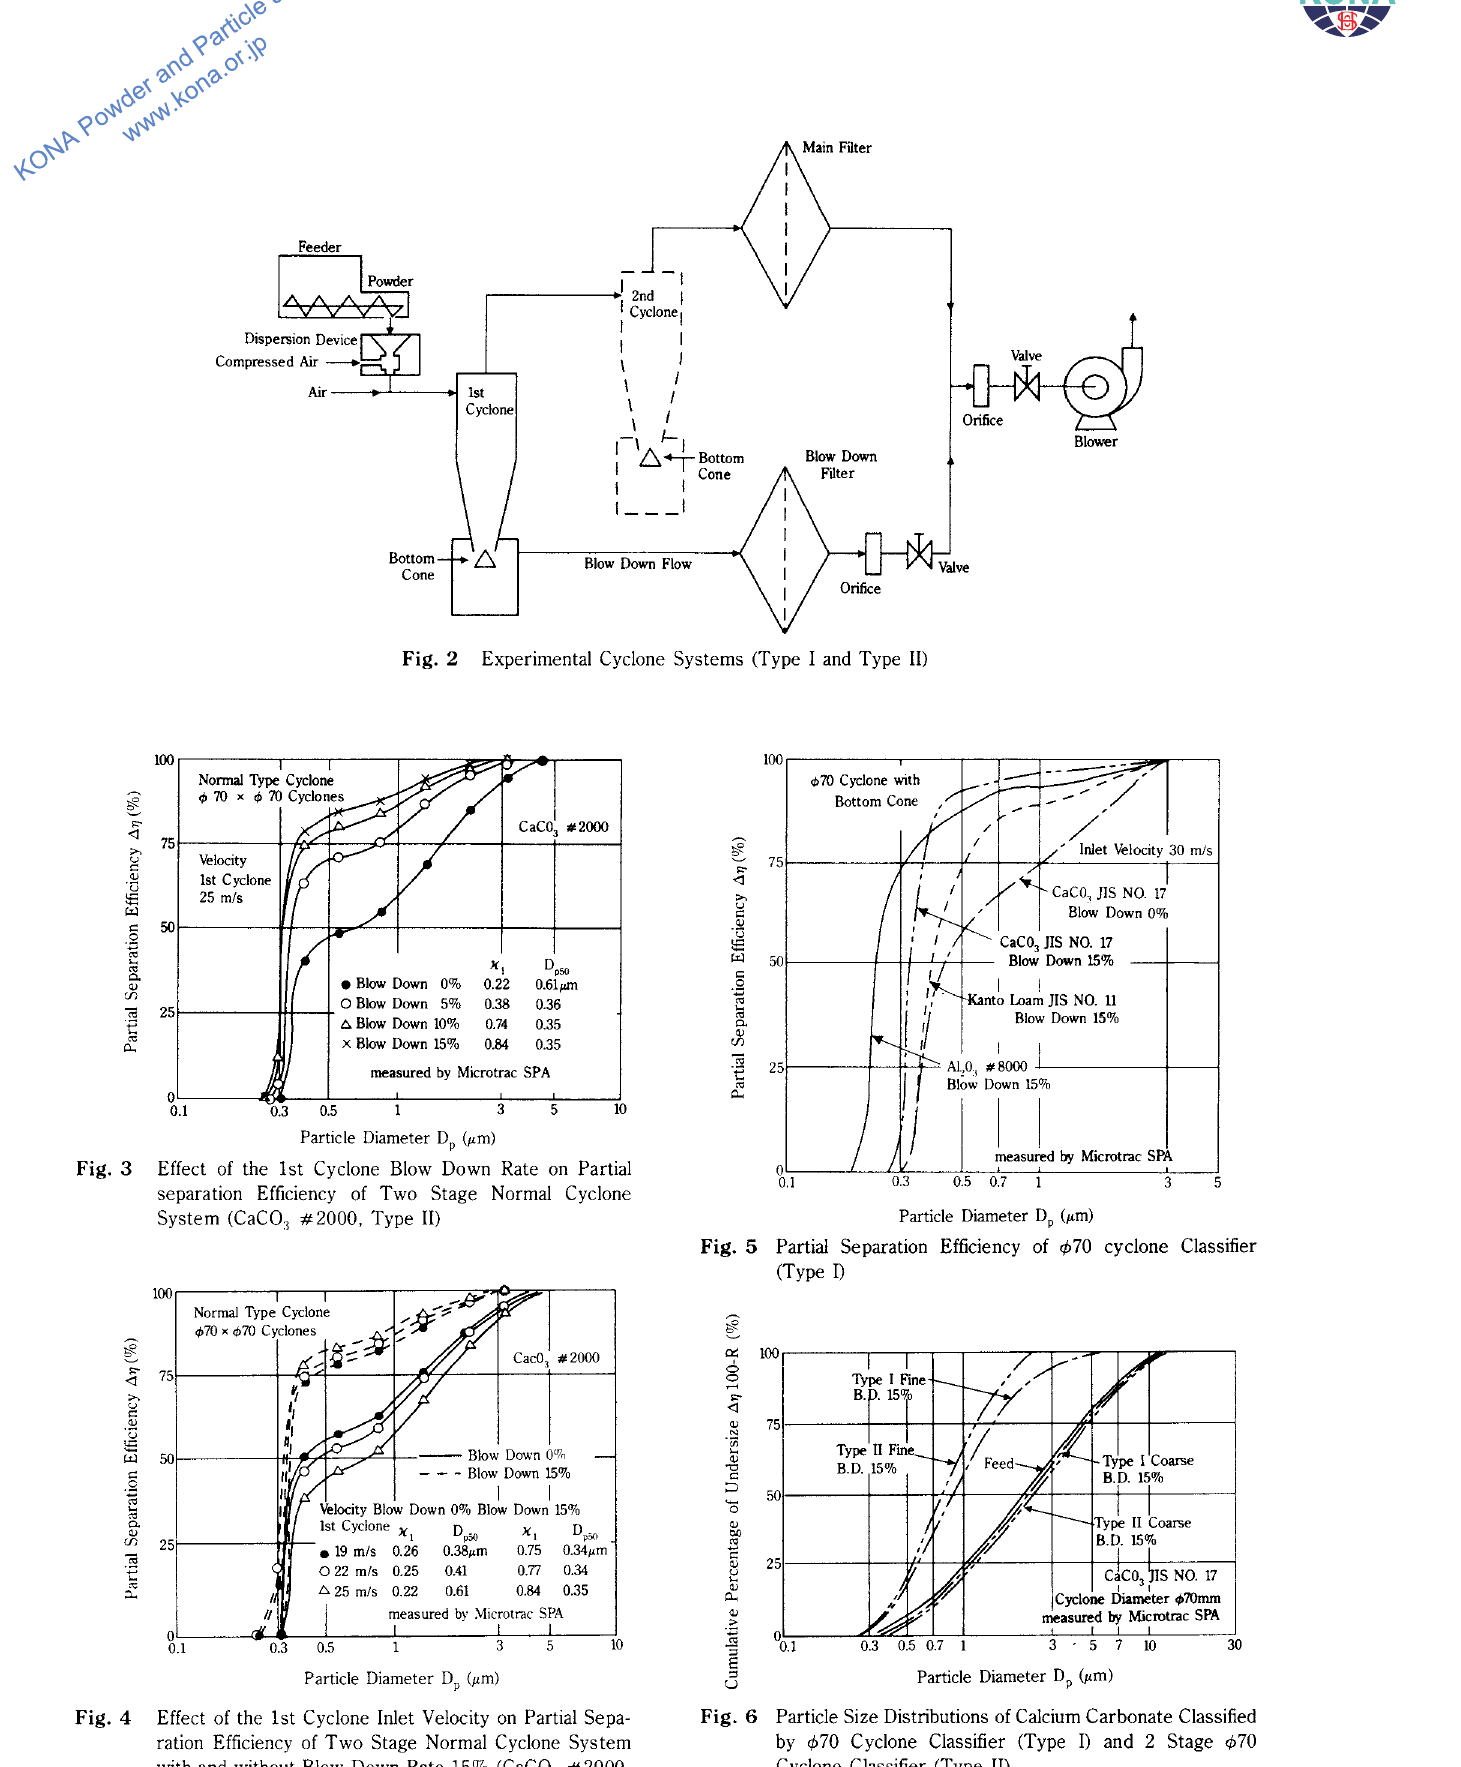
Effect of the 1st Cyclone Inlet Velocity on Partial Sepa ration Efficiency of Two Stage Normal Cyclone System with and without Blow Down Rate 15% (CaC0 Type II)